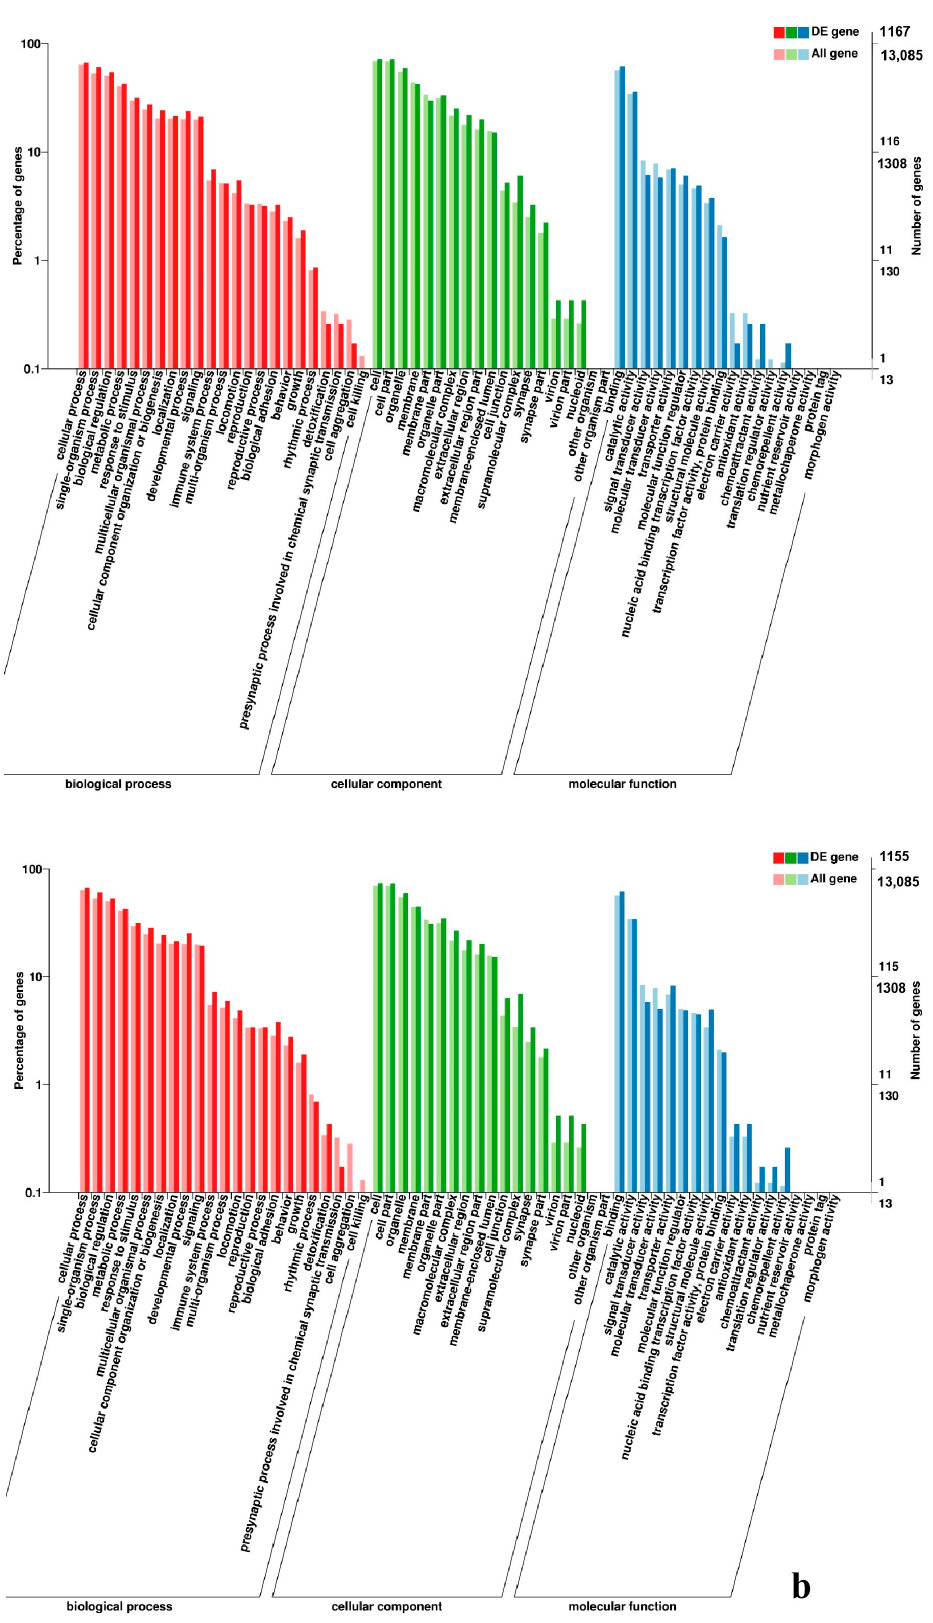
Figure 4. GO enrichment analysis of DEGs in breast muscle ( a ) BE17B_vs_BE31B; ( b )